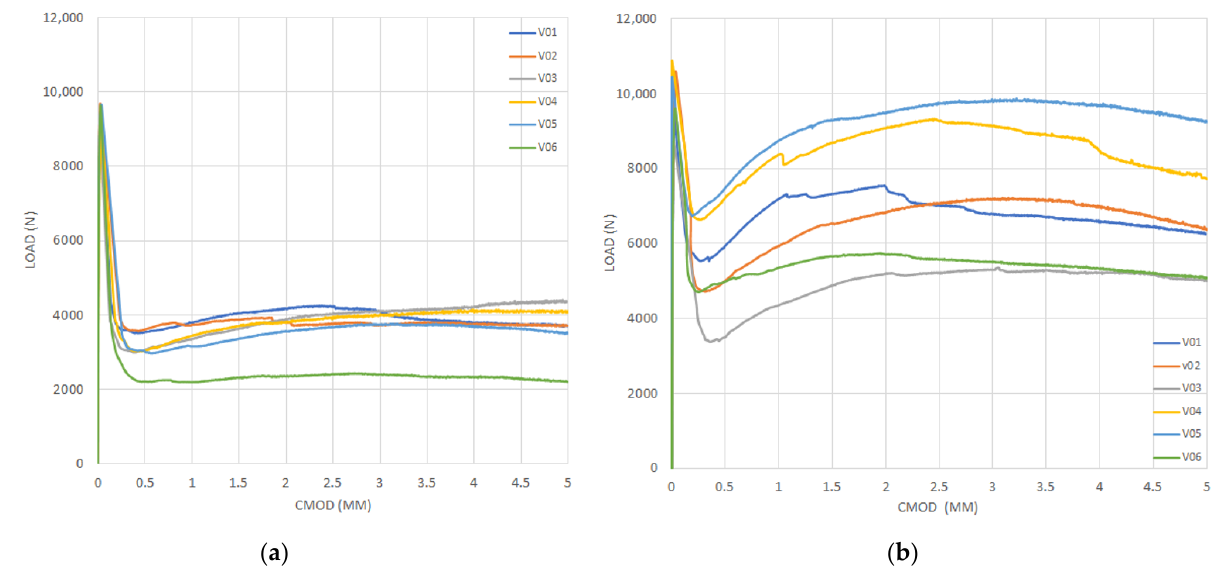
Figure 8. Curves of bending tensile test for the ratio (a/d) = 0.33: ( a ) Series 1 and ( b ) Series 2.